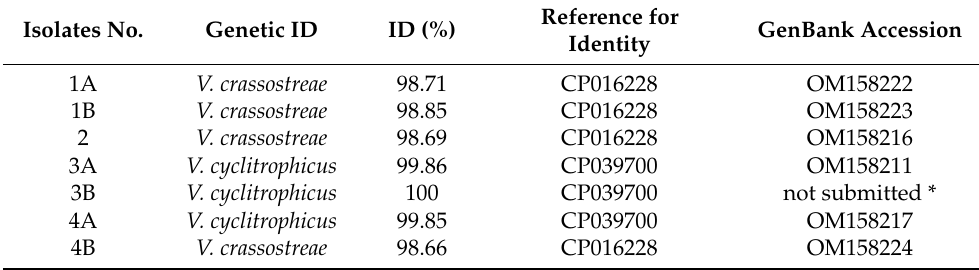
Table 2. Isolates identifier, identification (ID), percentage (%) of identity compared to reference sequences, and accession numbers of sequences deposited on GenBank. *: the sequences with an identity percentage equal to 100% to reference sequences already deposited on GenBank were not submitted.